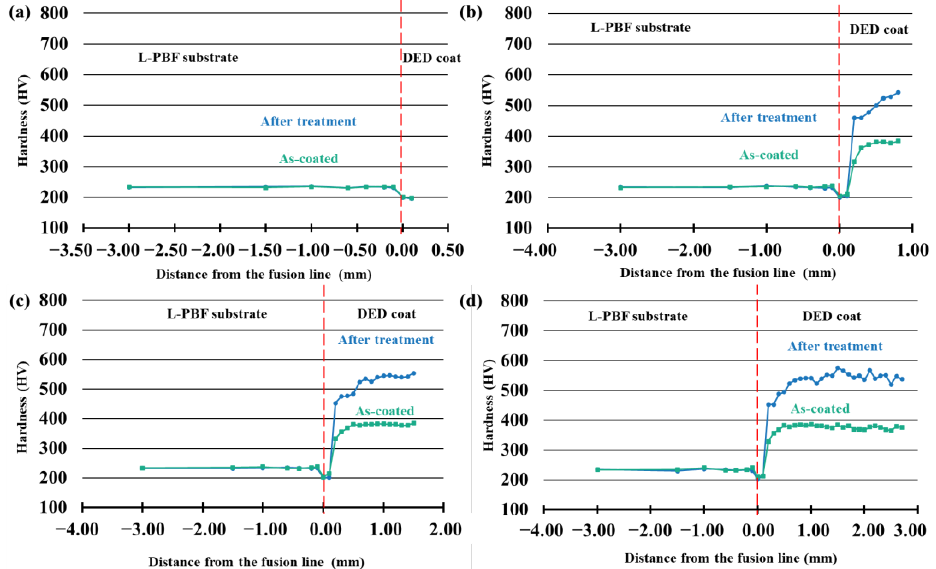
Figure 14. Hardness trends in as-coated and after treatment samples: ( a ) 1-layer, ( b ) 3-layer, ( c ) 5-layer, and ( d ) 10-layer.